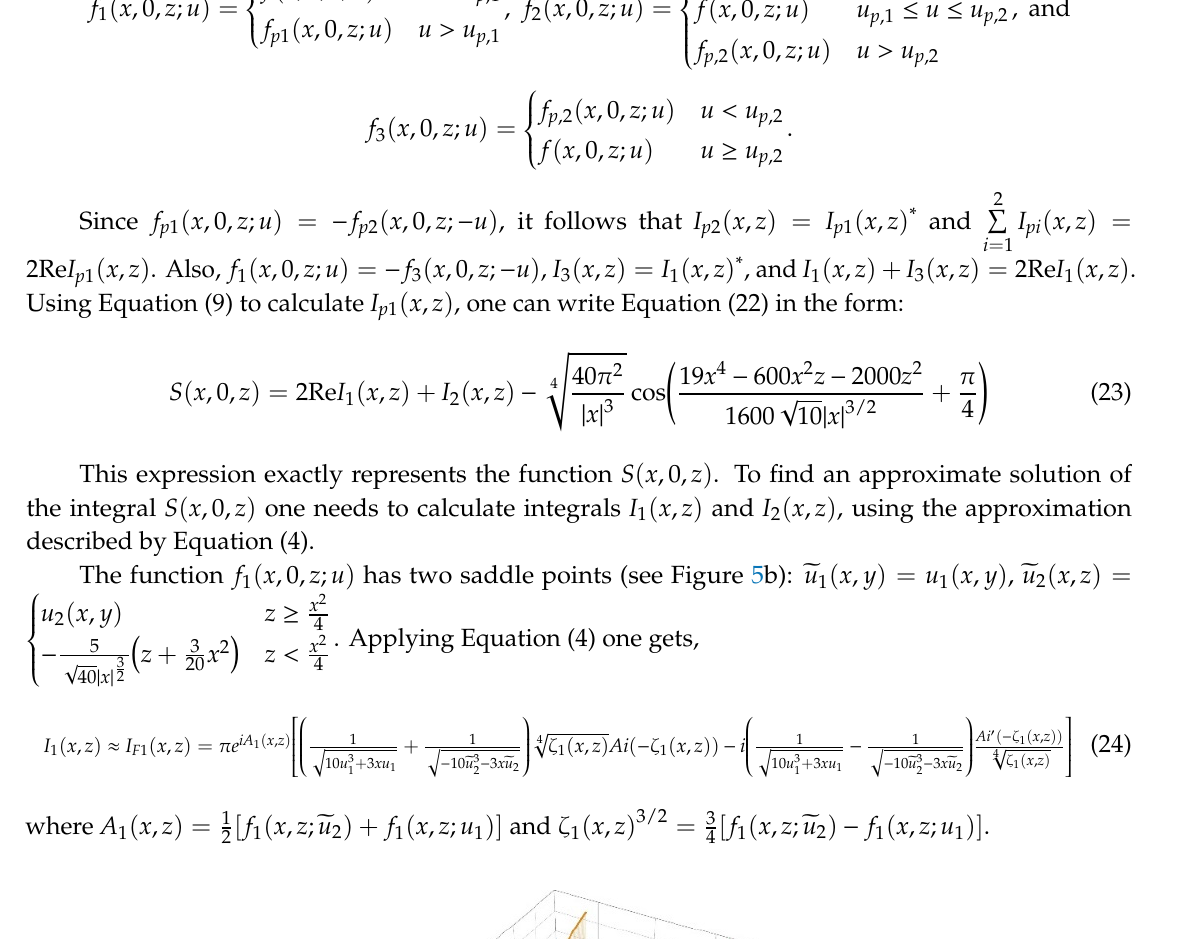
u ) of the functions